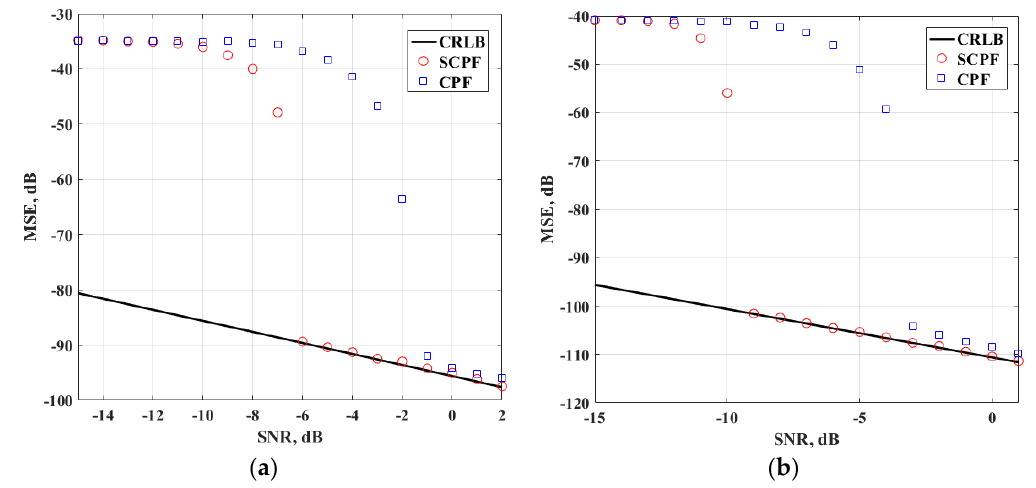
Figure 13. Mean squared error (MSE) performance of cubic phase function (CPF) and sequential cubic phase function (SCPF) vs. Cramer–Rao Lower Bound (CRLB): ( a ) N = 201; ( b ) N = 401.